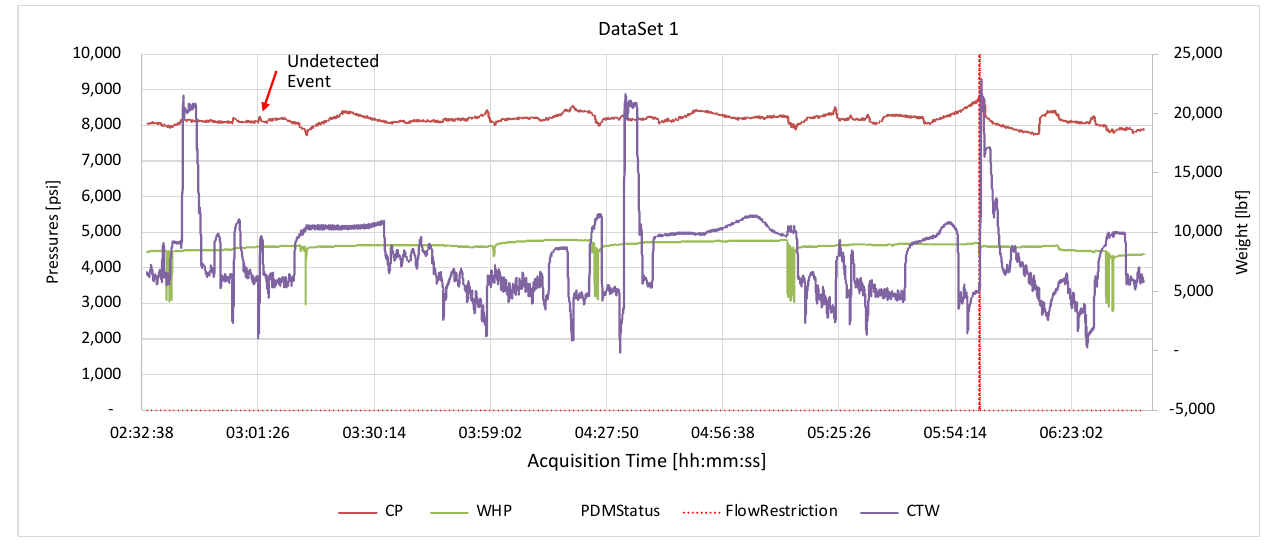
Figure 10. Plot for Dataset 1 datapoints and FIS outputs. At around 06:00, a FlowRestriction event is detected (denoted by the red vertical line) and this could be due to the fact that the motor was stalled and, while still having trapped pressure inside the housing, the operator started to remove the WOB by pulling up the CT string, which decreased the CTW_deviation back to N (Normal), and the FlowRestriction output was activated. This action of not waiting on the pressure to bleed off before moving up the tool string is an operational error by the operator side and could result in over- spinning of the PDM and, in the worst case, could lead to the rotor unscrewing from the PDM body and immediate failure of the tool. In a real case scenario, the PDMStatus output could be connected to an actuator on the CT unit that would not allow the CT pipe to move up even if the operator moves the lever to do so. The FIS detected 7 out of 8 stalls present in this data.